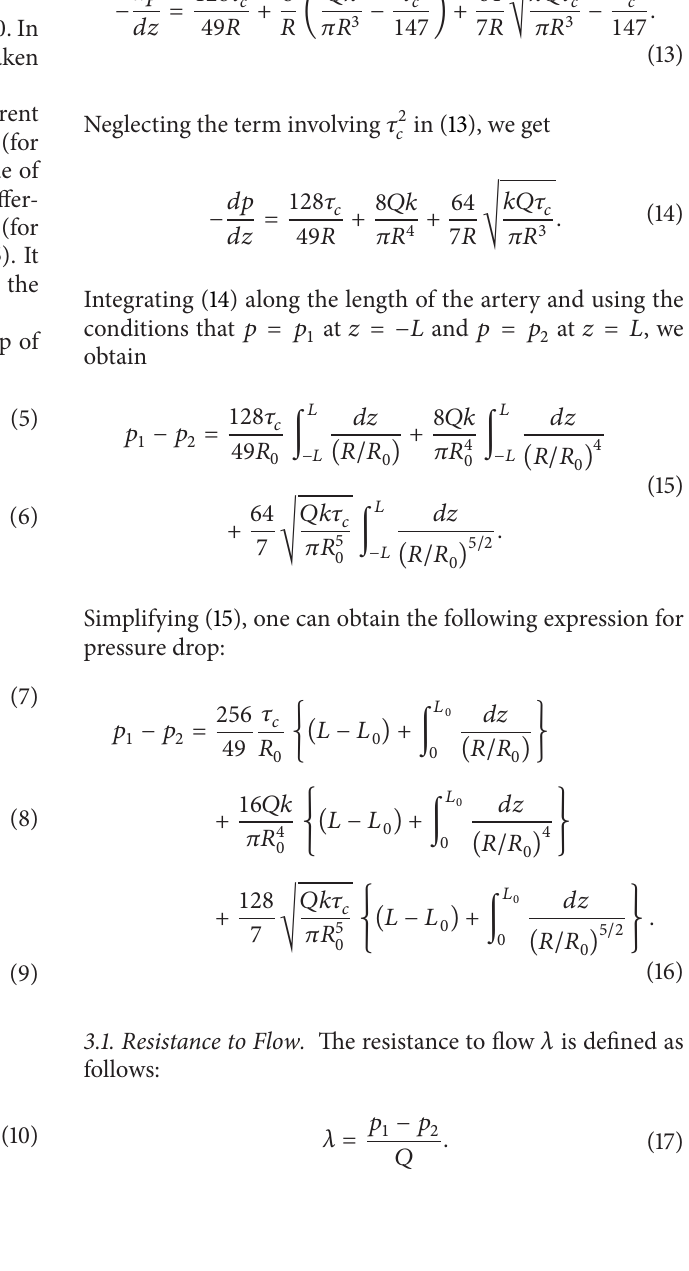
Figure 2. The percentage of stenosis is given by 𝐿 0 /𝐿×100 .